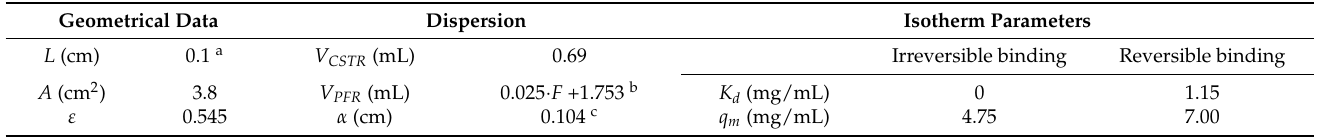
Table 1. Geometrical constants, system volumes and bi-Langmuir parameters related to the experi- mental system